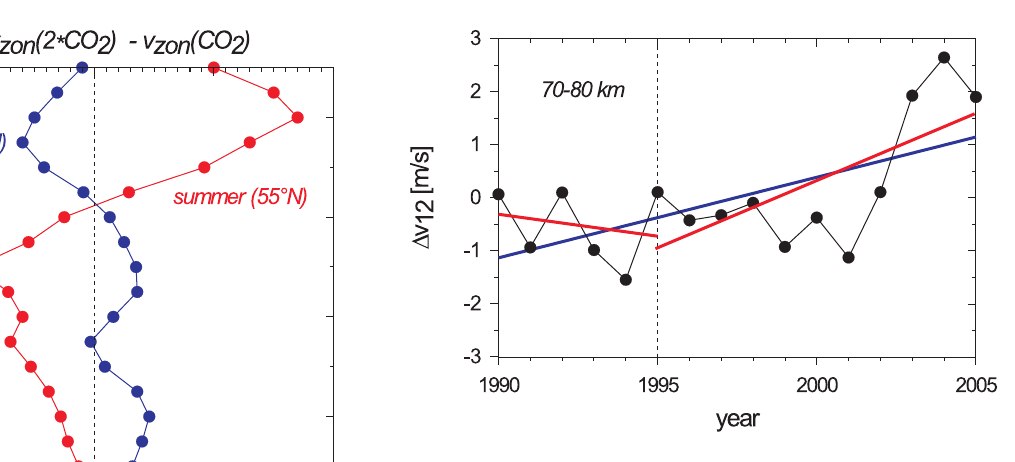
Fig. 21. Trends of the yearly averaged semidiurnal tidal amplitudes at Juliusruh for the height interval 70–80km after elimination of the solar induced parts derived for the full observation period from 1990 until 2005 (blue line) and for the two subintervals before and after 1995 (red